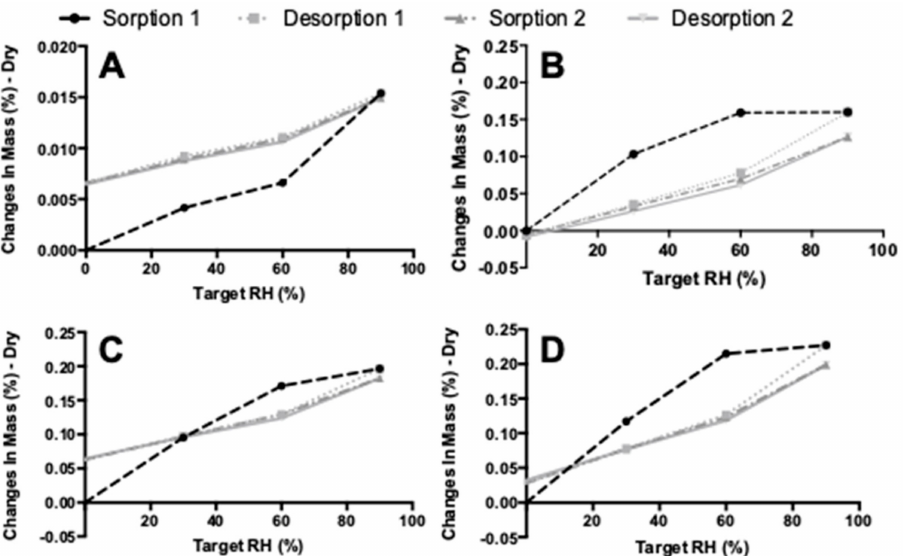
Figure 11. The dynamic vapor sorption (DVS) results. ( A ) shows the starting material results, ( B ) spray-dried isoniazid pure, ( C ) spray-dried isoniazid with 2% l -Leu, and ( D ) shows the spray-dried isoniazid with 4% l -Leu